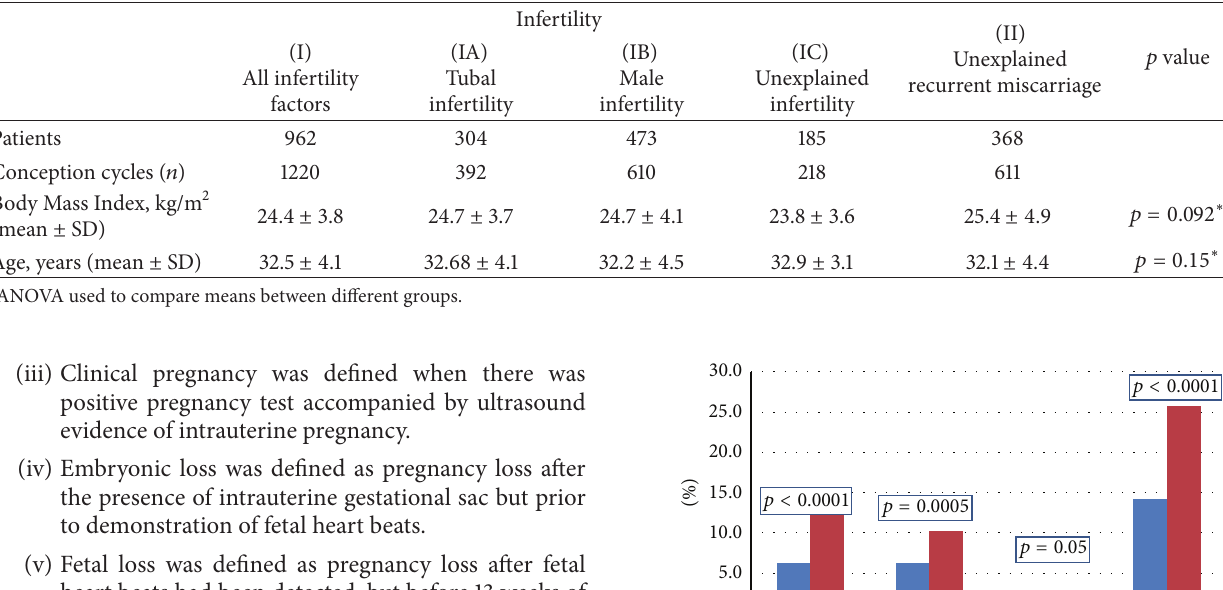
Table 1: Demographic data of women with recurrent miscarriage and infertility.